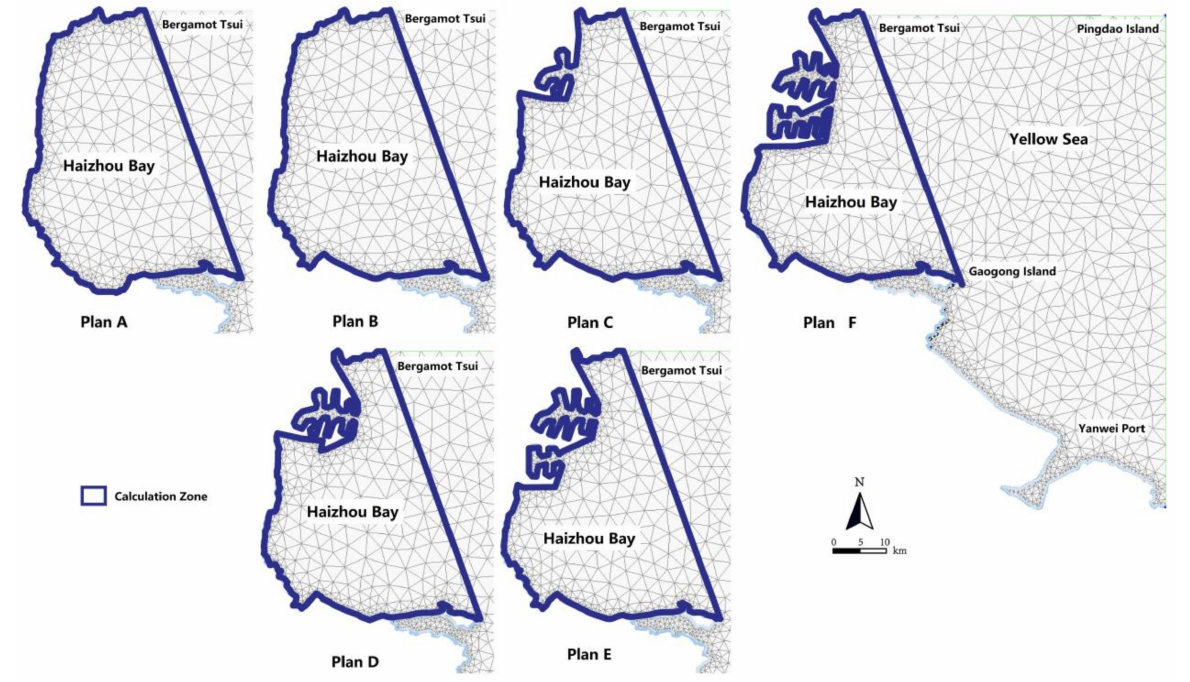
Figure 9. Computed region of marine EC (scenario 3). Computed region of plan A; computed region of plan B; computed region of plan C; computed region of plan D; computed region of plan E; computed region of plan F.